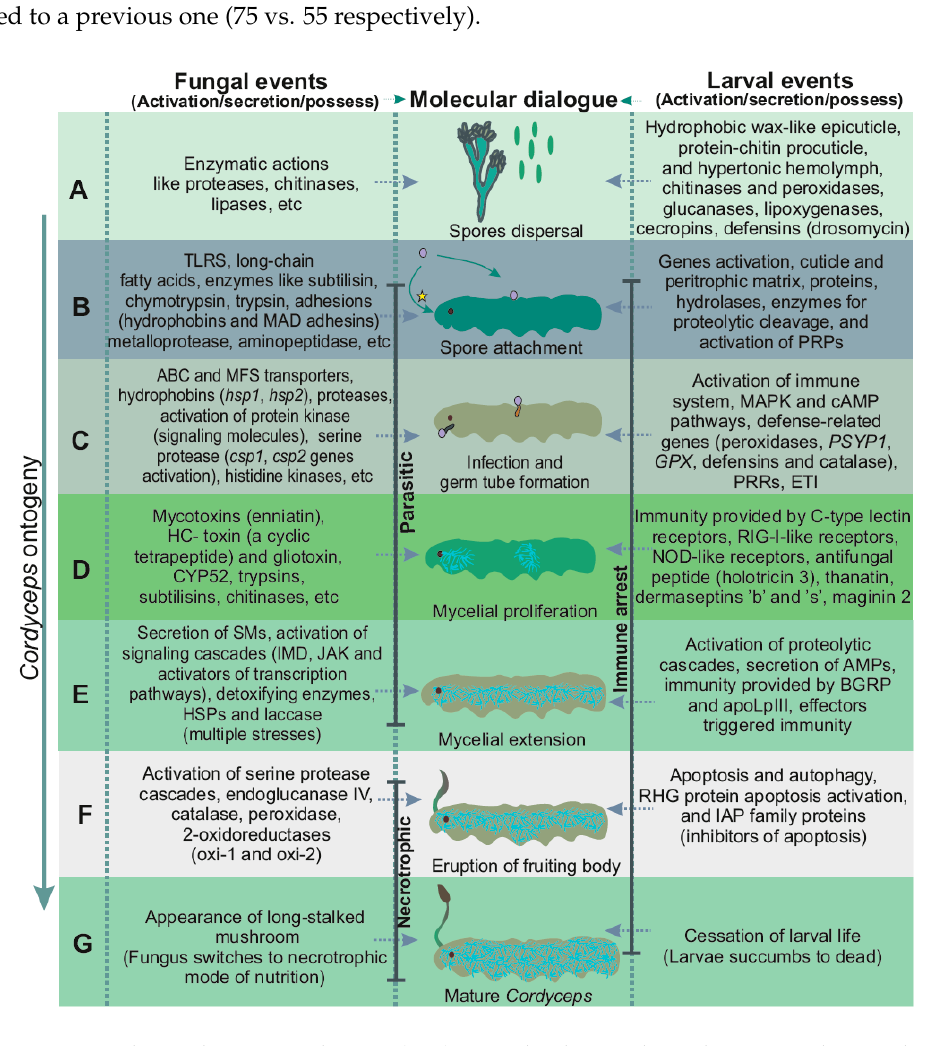
Figure 2. Fungal assault on insect larvae. ( A , B ) Spore landing and attachment: Sticky conidia are attached to larval cuticle by adhesins; ( C ) Infection and formation of germ tube: germination of conidia and extension of germ tube inside larval body; ( D ) Proliferation of mycelium: within larval body, hyphae extend continuously, giving rise to an extensive mycelial mass; ( E ) Extension of fungal mycelium: mycelium extends throughout larval body, colonizing every organ; ( F ) Eruption of fruiting body (ascocarp): soon after body gets colonized by fungal mycelium, it proliferates out from frontal cortex just between the eyes; ( G ) Mature Cordyceps : Cordyceps after erupting from larval head (larvae of Himalayan bat moth Hepialus armonicanus). * This entry-route of infection in Cordyceps is still unclear and thus requires further justification.